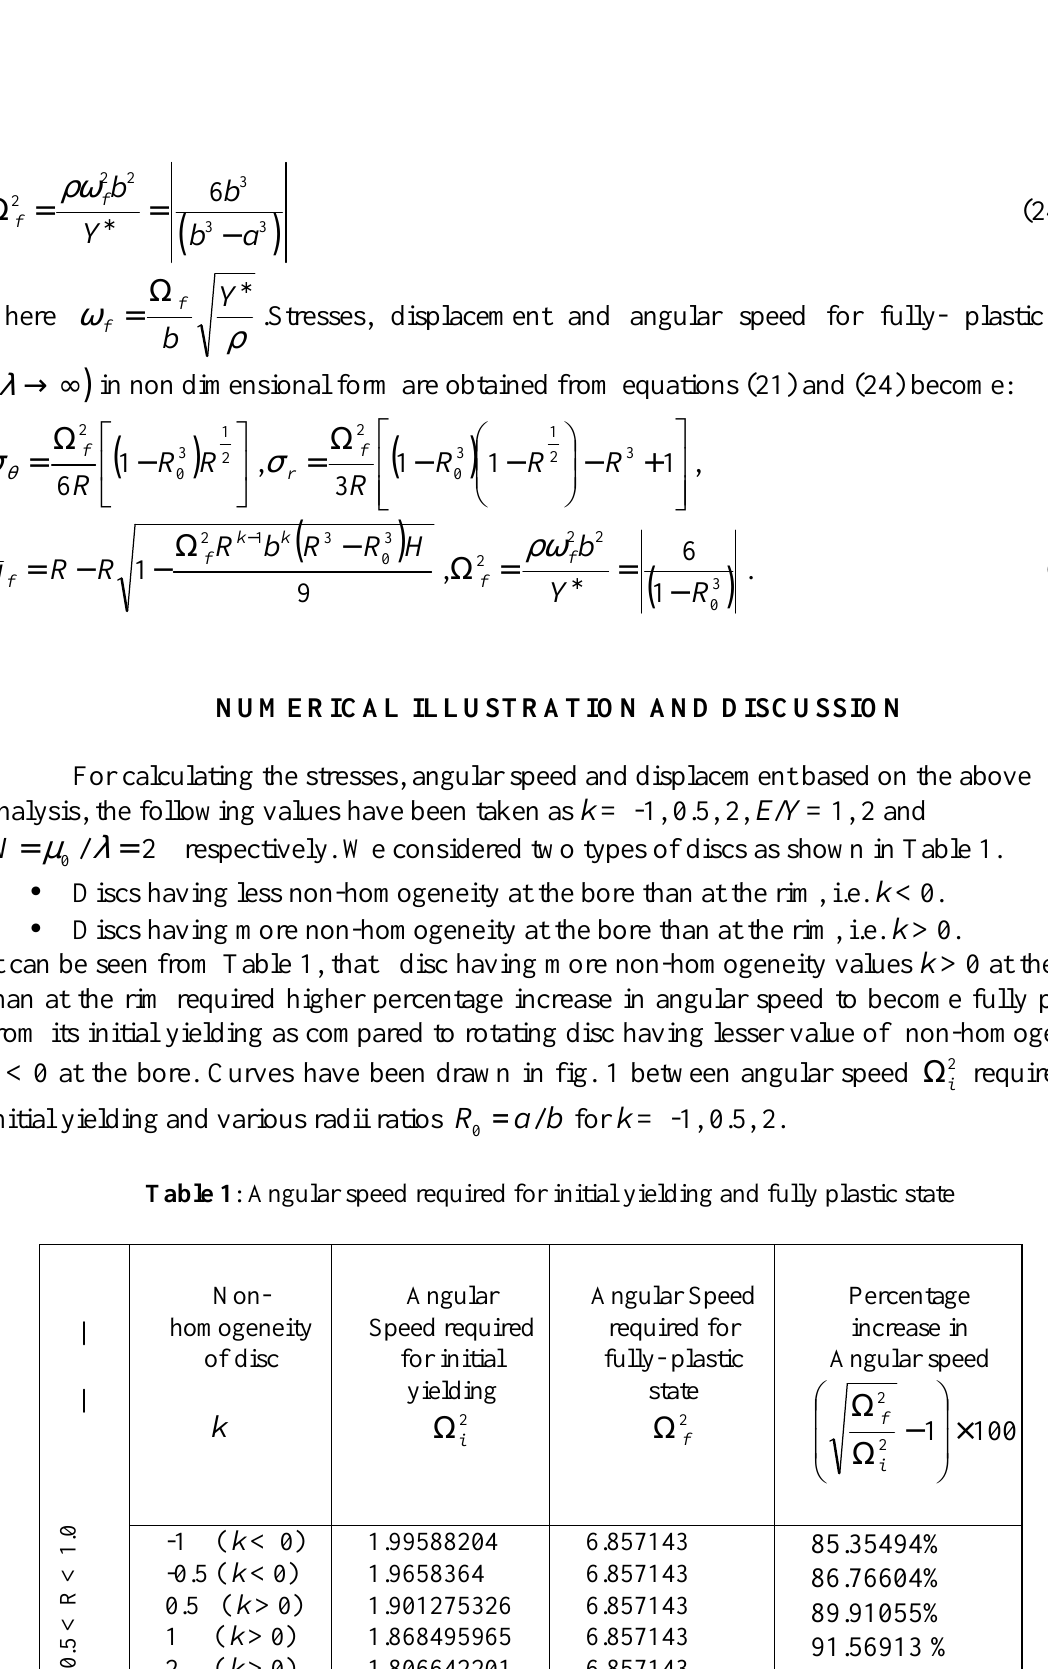
Non- homogeneity of disc